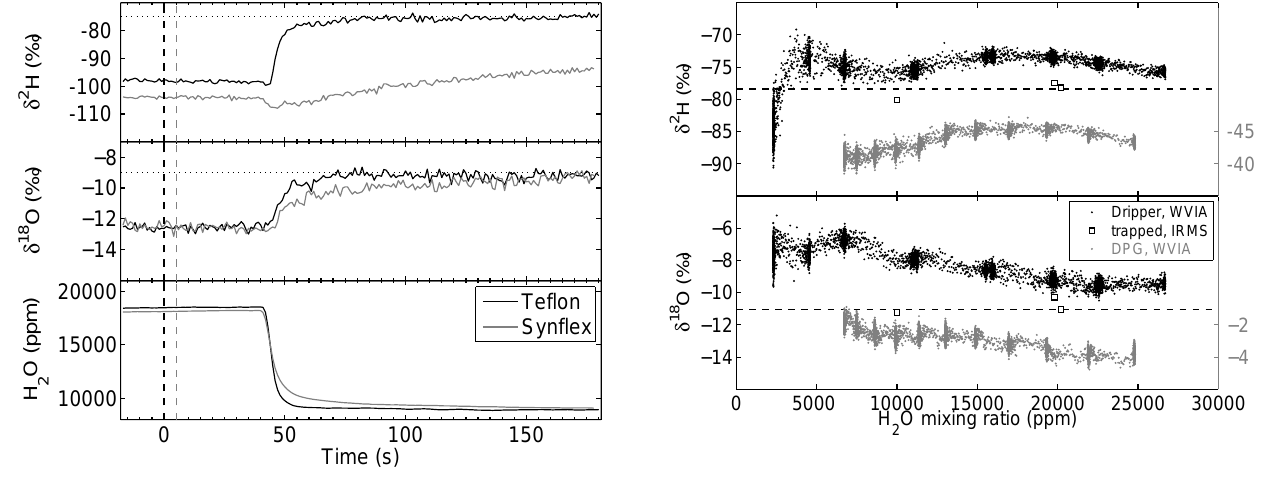
Fig. 5. Response time of a step change when inlet air is switched from sample to calibration and led to the WVIA through ∼ 32m of PTFE (Teflon) tubing (black line) or ∼ 27m of Synflex tubing (grey line), respectively, at a flow rate of 450mLmin − 1 . The Synflex data are shifted by 5s to account for the smaller time lag after the switch (dashed lines) due to the shorter tubing length. The dotted lines are the target values of the isotope ratios.